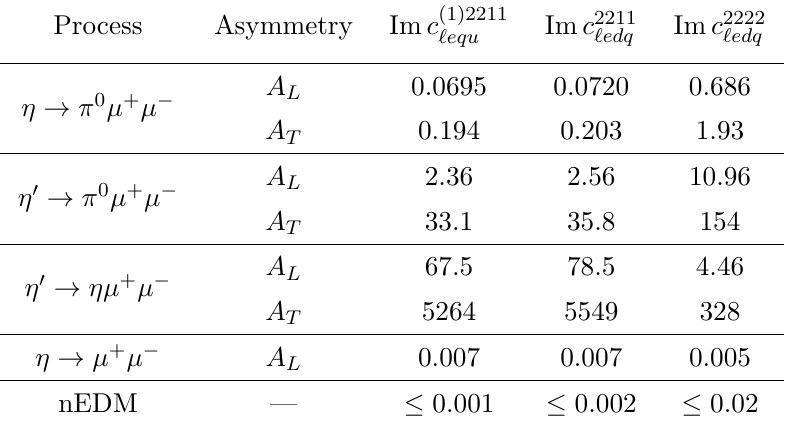
Table 1 . Summary of REDTOP sensitivities to (the imaginary parts of) the Wilson coefficients associated to the SMEFT CP -violating operators in eq. (2.2) for the processes studied in this work, as well as the η → µ + µ − decay analysed in ref. [4]. In addition, the upper bounds from nEDM experiments are given in the last row for comparison